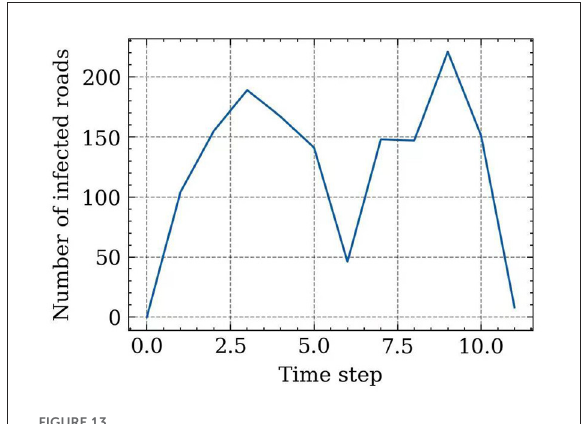
FIGURE13 The number of infected roads at each time step of trajectory-based propagation.